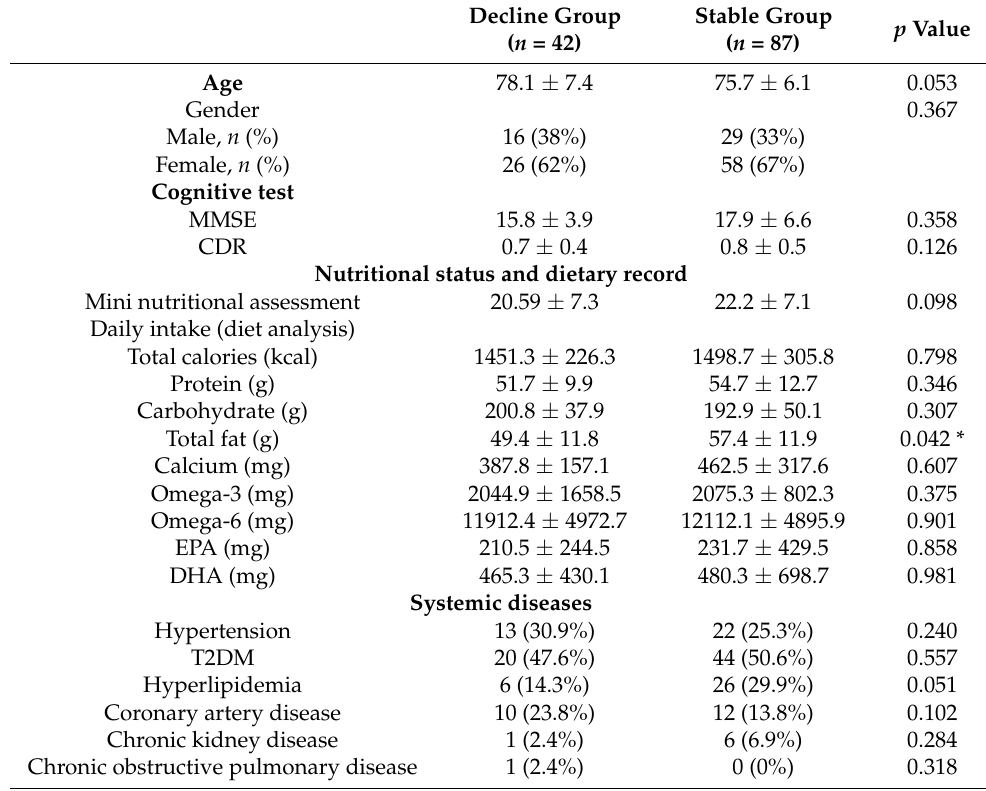
Table 1. Demographic characteristics of patients with AD receiving AChEIs in two